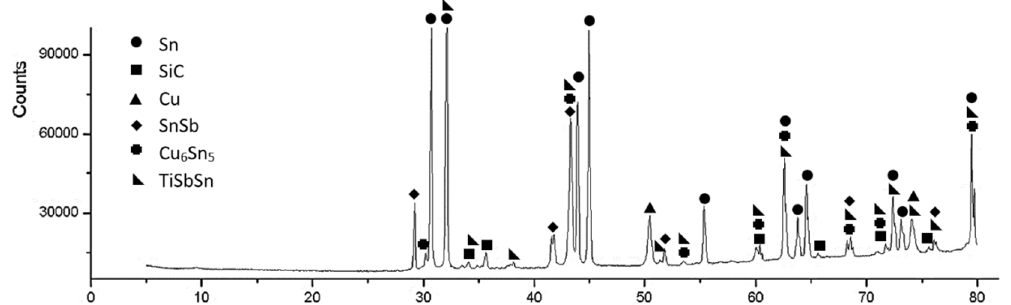
Figure 27. XRD analysis of the boundary in the SiC/Sn5Sb3Ti/CuSiC joint .